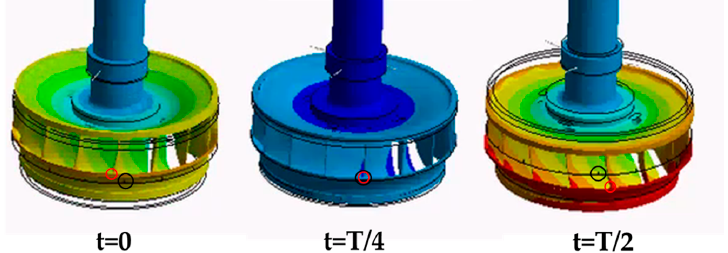
Figure 18. Total displacement of the runner during the cycle. Red color maximum displacement and blue color minimum displacement. The black line represent the non-deformed runner. The black and red circles are used to see the relative displacement of one blade, being the black circle always in the same point and the red circle moving with the blade displacement.